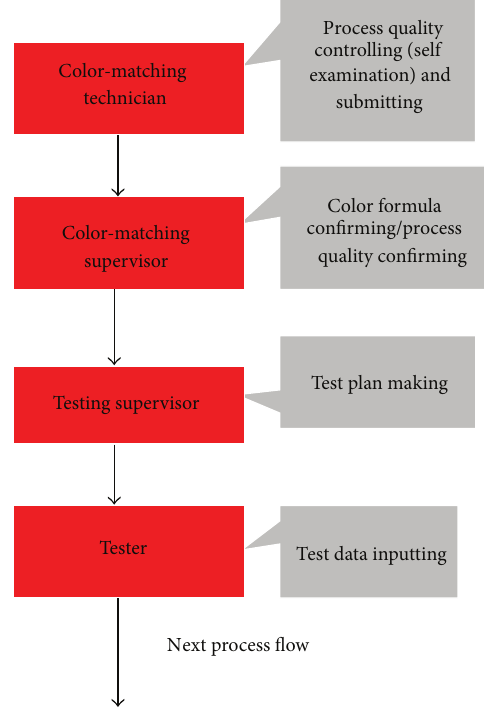
Figure 4: Flow chart of testing and judging and putting into